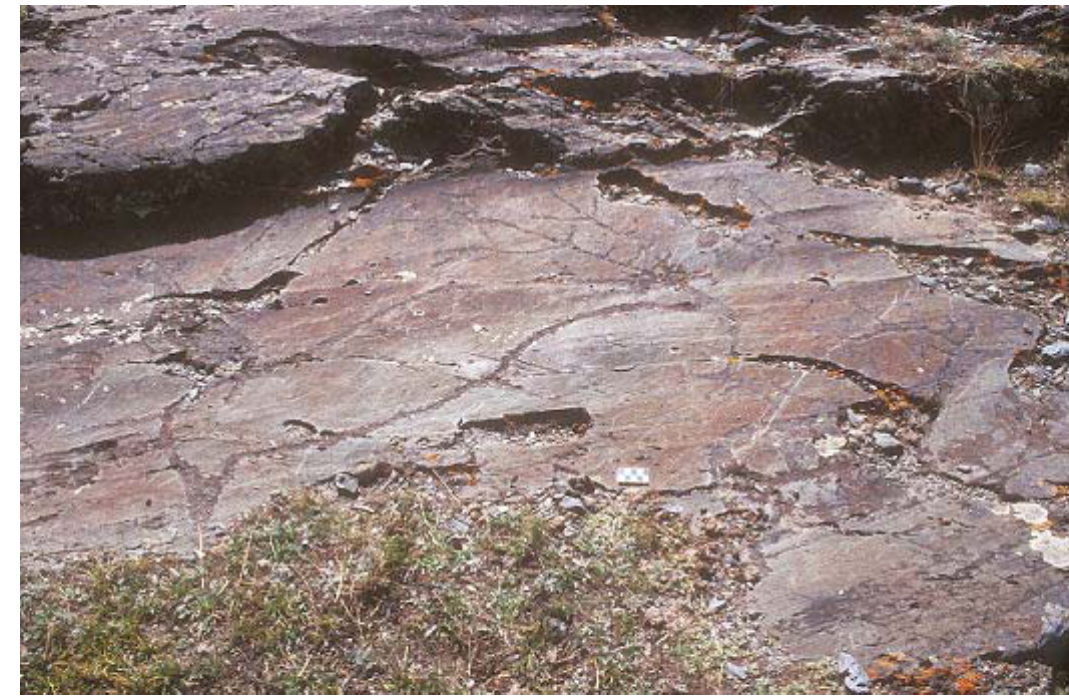
Figure 7. Elk overlaid by an argali. Pre-Bronze Age. Aral Tolgoi.